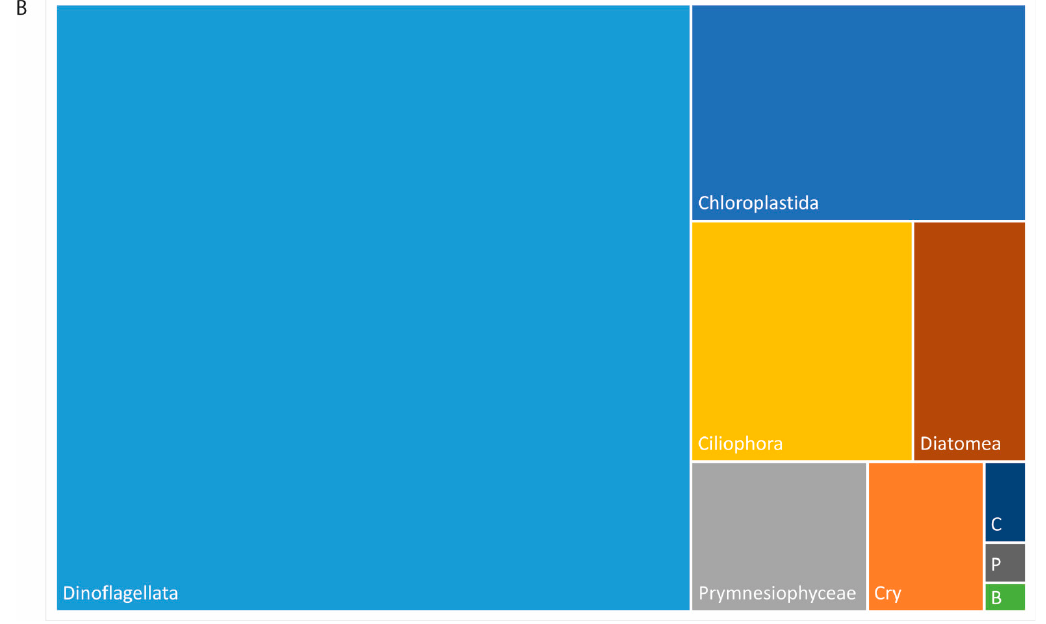
Figure 6. Taxa summary chart of WaMS samples from 2011–2012 partial 18S rDNA HTS reads at level L3 ( A ). Dots next to each sample indicate coastal samples. Colored lines indicate the season the sample was taken. Summary plot of average phytoplankton taxa proportions from Table S5, Cry: Cryptomonadales, B: Bicosoecida, C: Chrysophyceae, P: Pelagophyceae, Ciliophora is represented by Mesodiniidae with members that acquire photosynthesis ( B ).